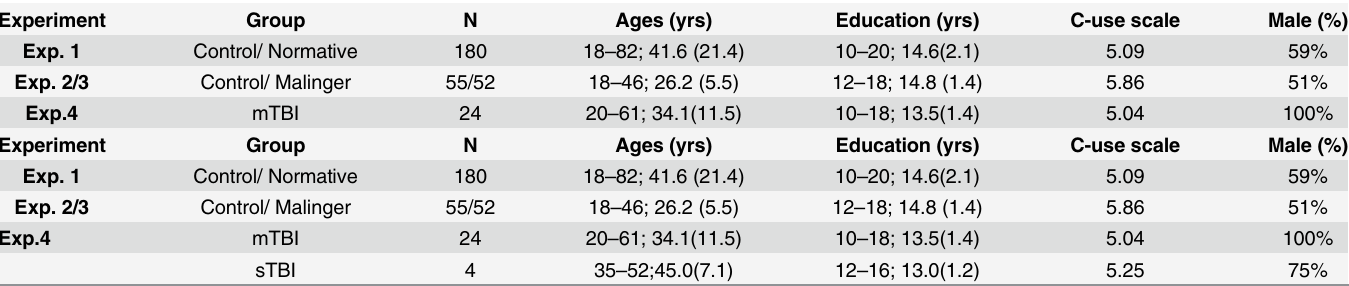
Table 2. Participant